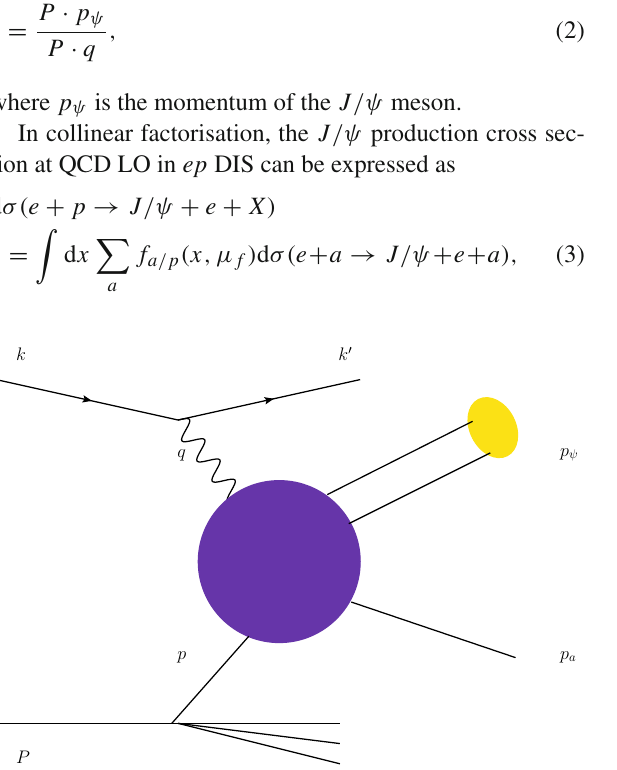
Fig. 1 The illustrative diagram for the J /ψ production in